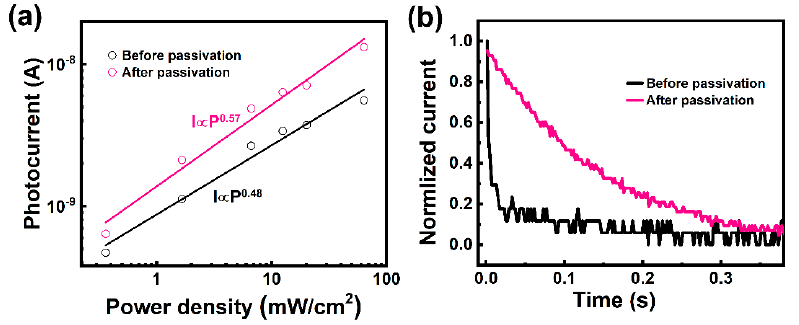
Figure 2. ( a ) Dependence of photocurrent and power intensity before and after passivation. ( b ) Time-dependent current decay curve of GaAs 2DNLS photodetector before and after passivation.